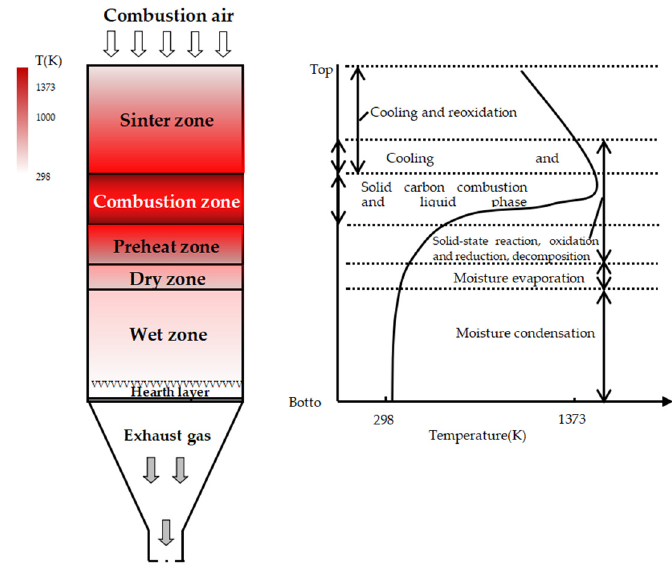
Materials 2021 , 14 , x FOR PEER REVIEW Figure 11. Schematic diagram of the sintering reaction. Figure 11. Schematic diagram of the sintering reaction.